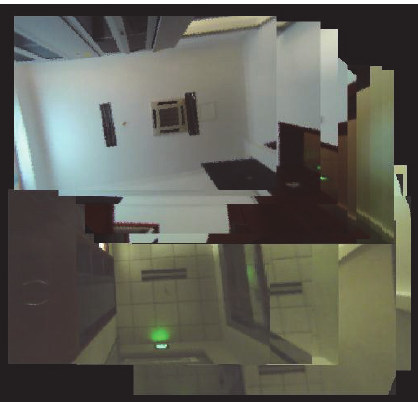
Figure 17: The global map for kidnap test described by keyframes sequence.